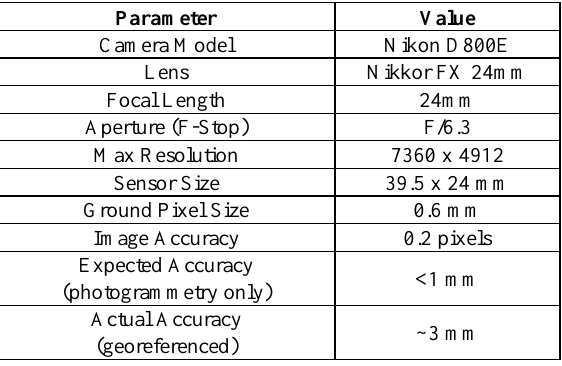
Table 1 – Photogrammetry Camera and Lens